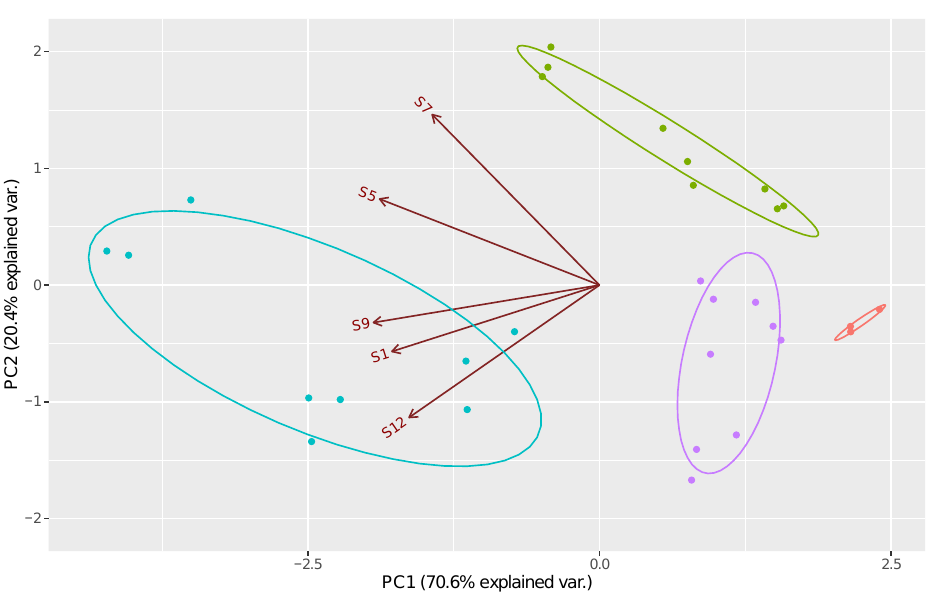
Table 3. Sensitivity (SRSS) and selectivity (SED) of the optimized and random sensor arrays.